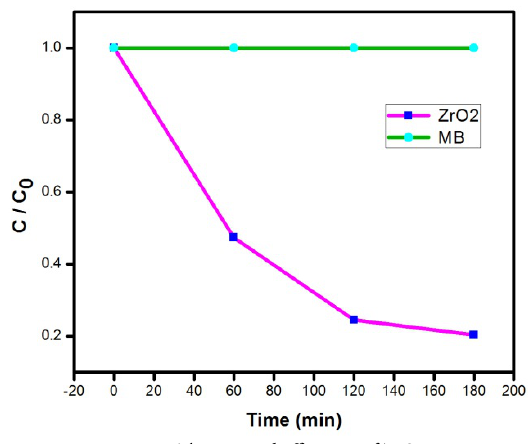
Fig. 12. The removal efficiency of ZrO2 Table 1. Comparison of photocatalytic activity of different catalysts